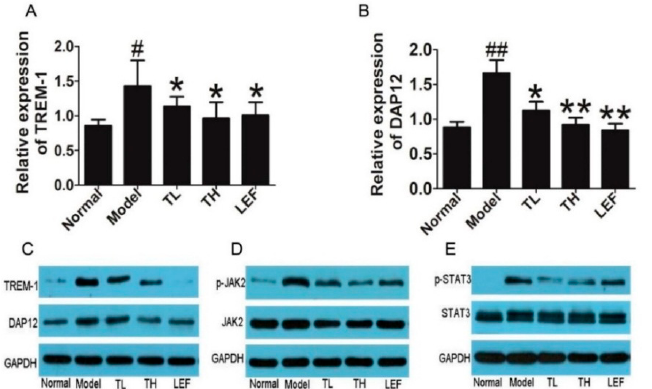
Figure 6. Effects of TP on the expression of TREM-1 and DAP12 in ankle joints of CIA rats. ( A , B ) TREM-1 and DAP12 mRNA levels in the ankle joints of CIA rats after treatment with TP; ( C ) Protein expression of TREM-1 and DAP12 in the ankle joints of CIA rats; ( D ) Expression of p-JAK2 in the ankle joints of CIA rats; and ( E ) Expression of p-STAT3 in the ankle joints of CIA rats. Date are represented as the mean ± SD ( n = 7), # p < 0.05, ## p < 0.01, in comparison with the normal group; * p < 0.05, ** p < 0.01, comparison with the model group.